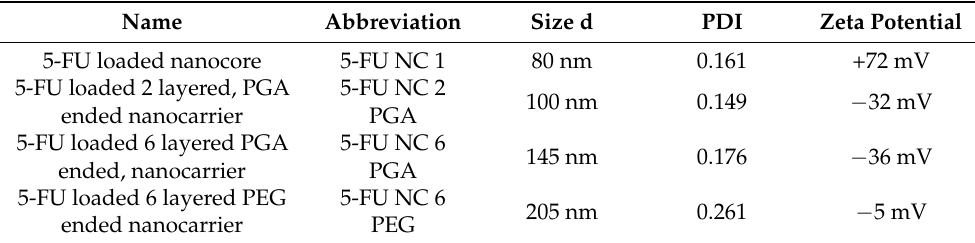
Table 1. Characterization of selected 5-FU nanocarriers.